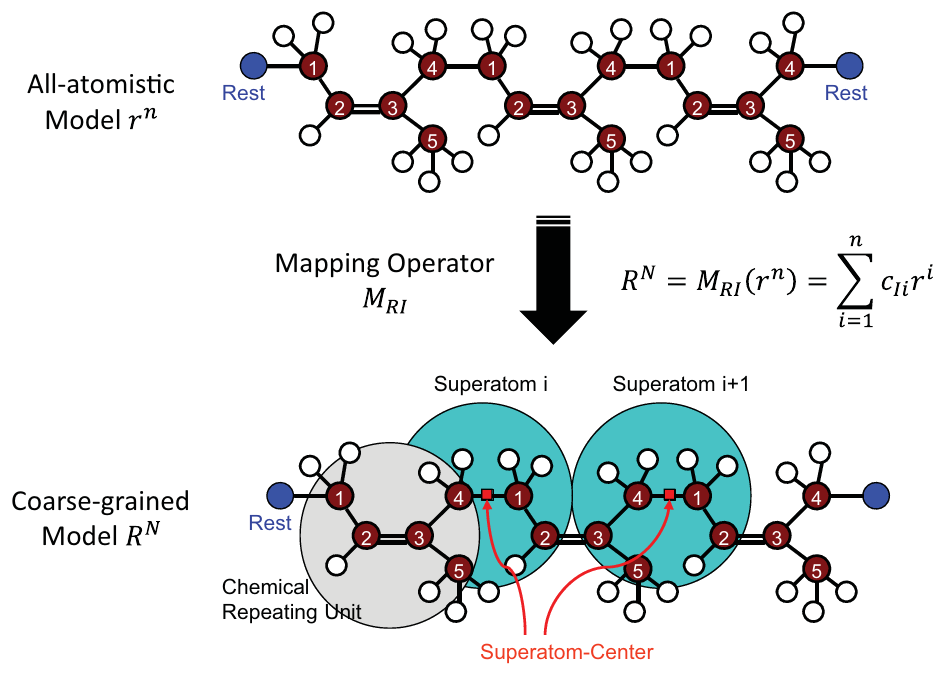
Figure 6. Illustration for mapping from the all-atomistic model ( r n ) to the coarse-grained model ( R N ), with a mapping operator, M , using the polymer cis RI